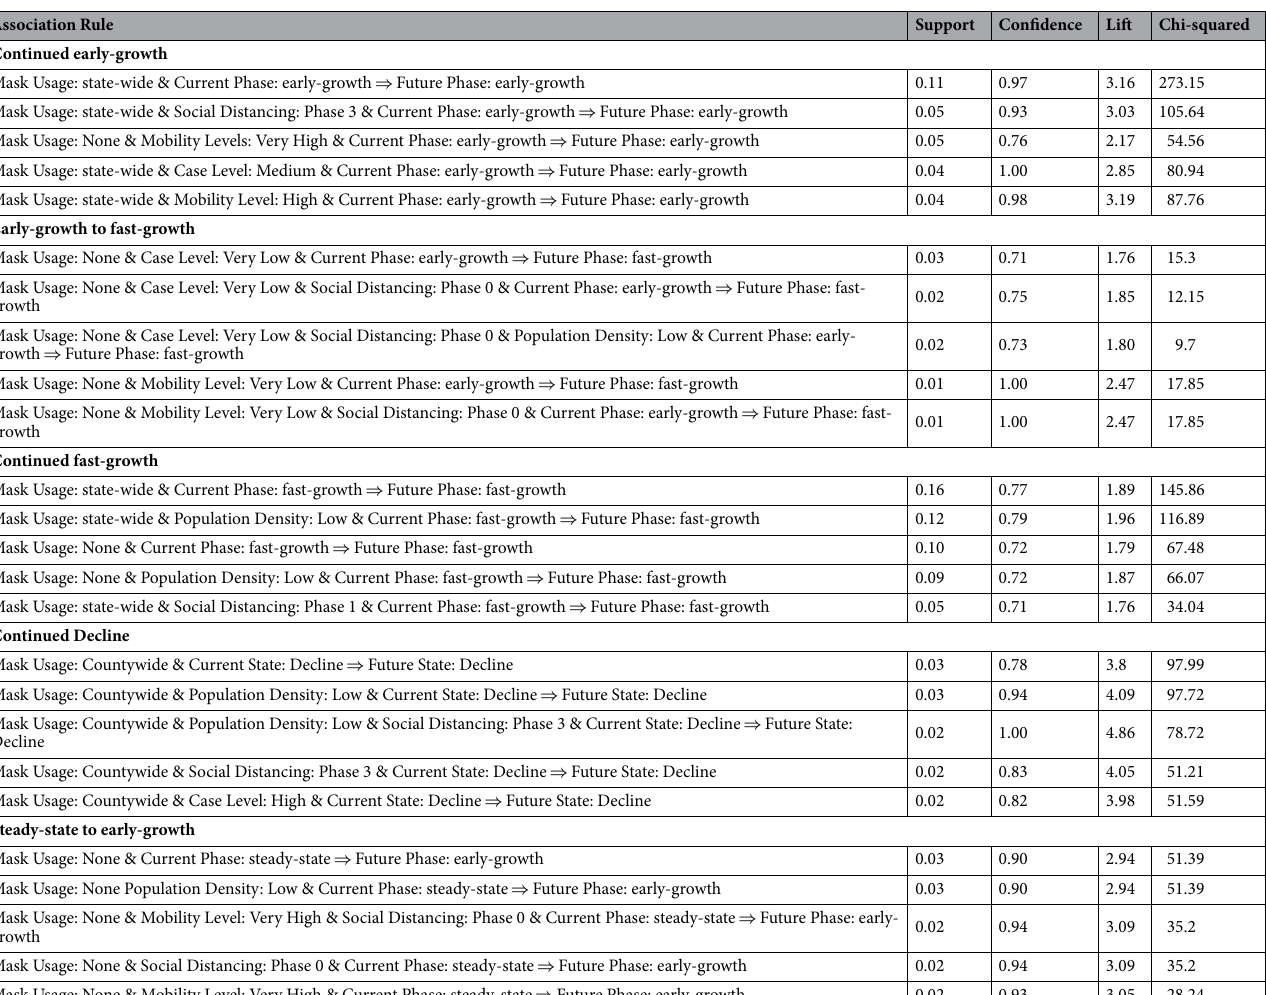
Support Confidence